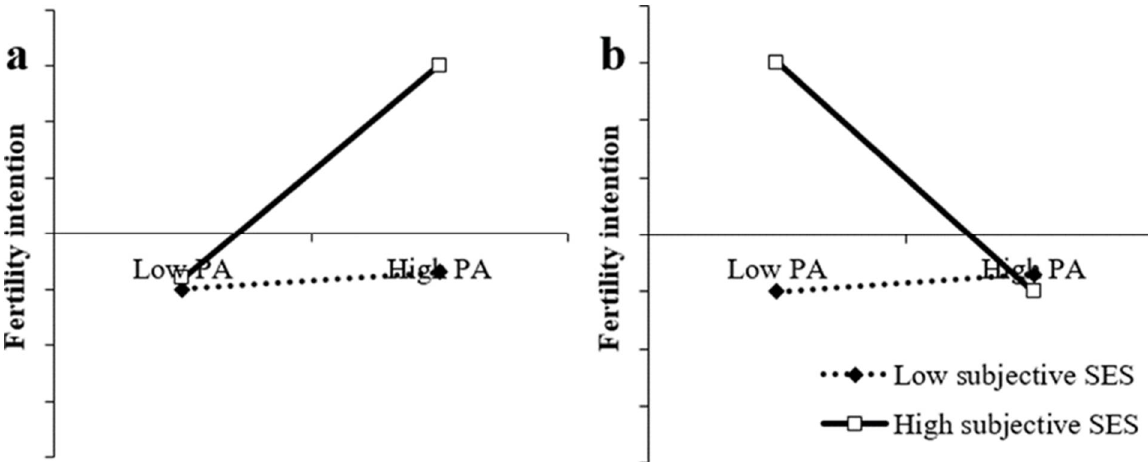
Figure 1. Model of the hypothetical pet attachment × subjective SES interaction depicting ( a ) an interaction in which pet attachment promotes fertility intention in individuals with high subjective SES but a nonsignificant relationship between pet attachment and fertility intention in individuals with low subjective SES; ( b ) an interaction in which pet attachment inhibits fertility intention in individuals with high subjective SES but a nonsignificant relationship between pet attachment and fertility intention in individuals with low subjective SES.